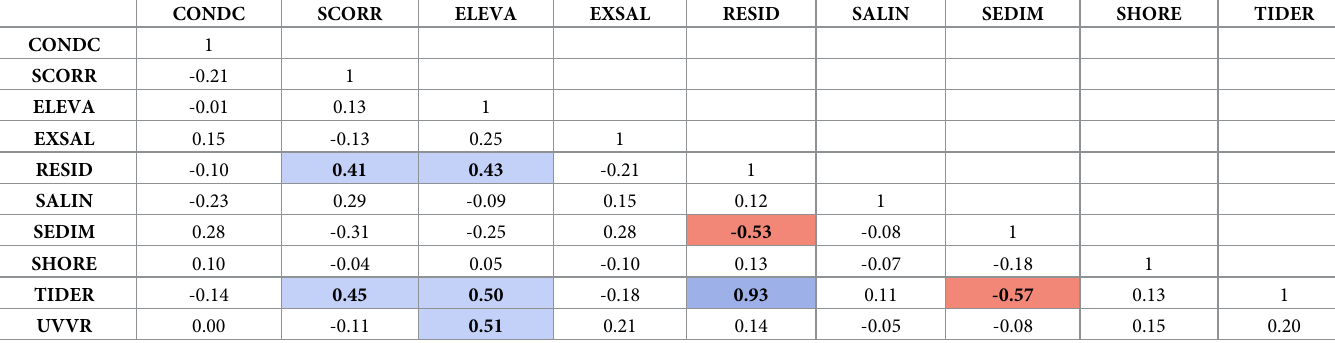
Table 2. Table of correlation coefficients. Correlation between the vulnerability indicators shown in Table 1. Positive indicates contribution to vulnerability in the same direction. Blue indicates correlations above 0.4. Red shows correlations lower than